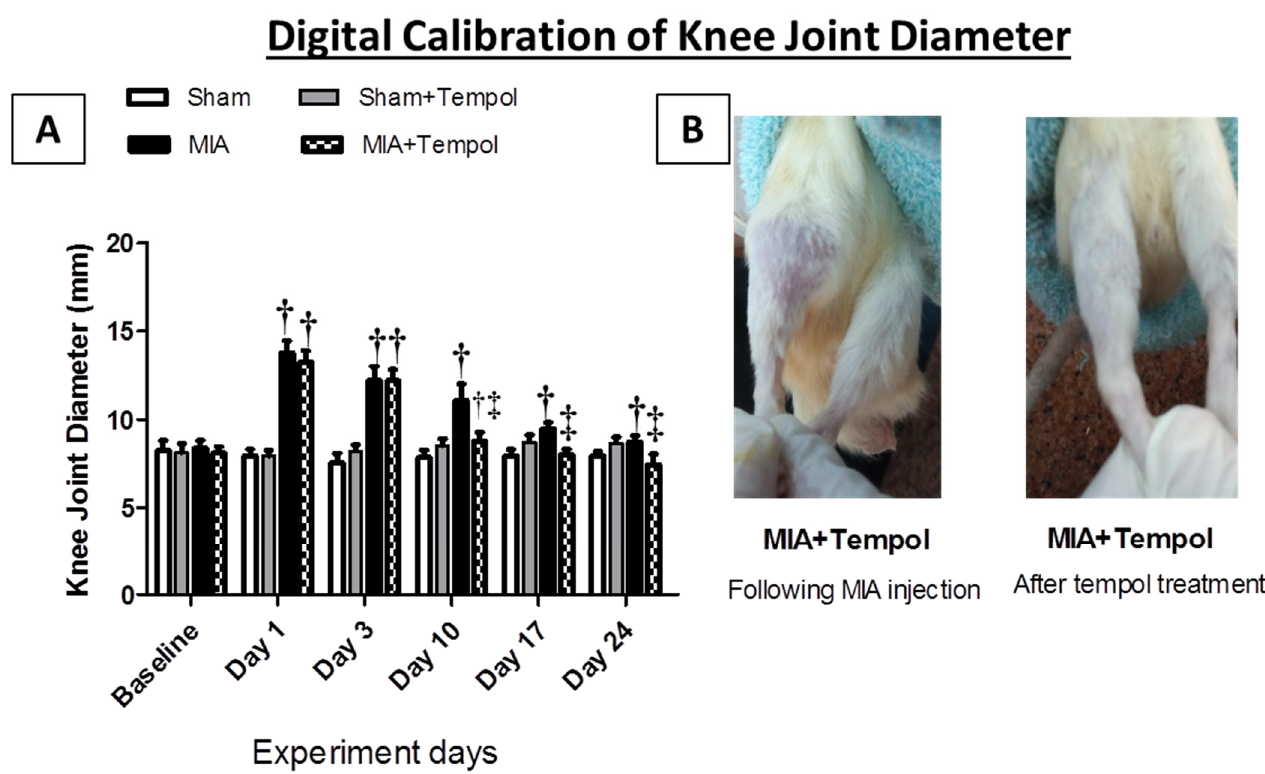
Figure 1. Effect of Tempol on the digital caliper test. Rats were subjected to a single intra-articular injection of 3 mg MIA/50 µ L saline in their right knees, and then tempol was administered starting from the 7th day of the experiment in a dose of (100 mg/kg/day) by oral gavage for 21 consecutive days. ( A ) Values of knee joint diameter are expressed as mean ± SD ( n = 8). Statistical analysis was carried out using repeated measures ANOVA test for factors time and group, followed by the Bonferroni test. † p < 0.05 vs. the sham group, and ‡ p < 0.05 vs. MIA group. ( B ) Gross image of MIA + Tempol group just after MIA injection and in the end of the experiment.